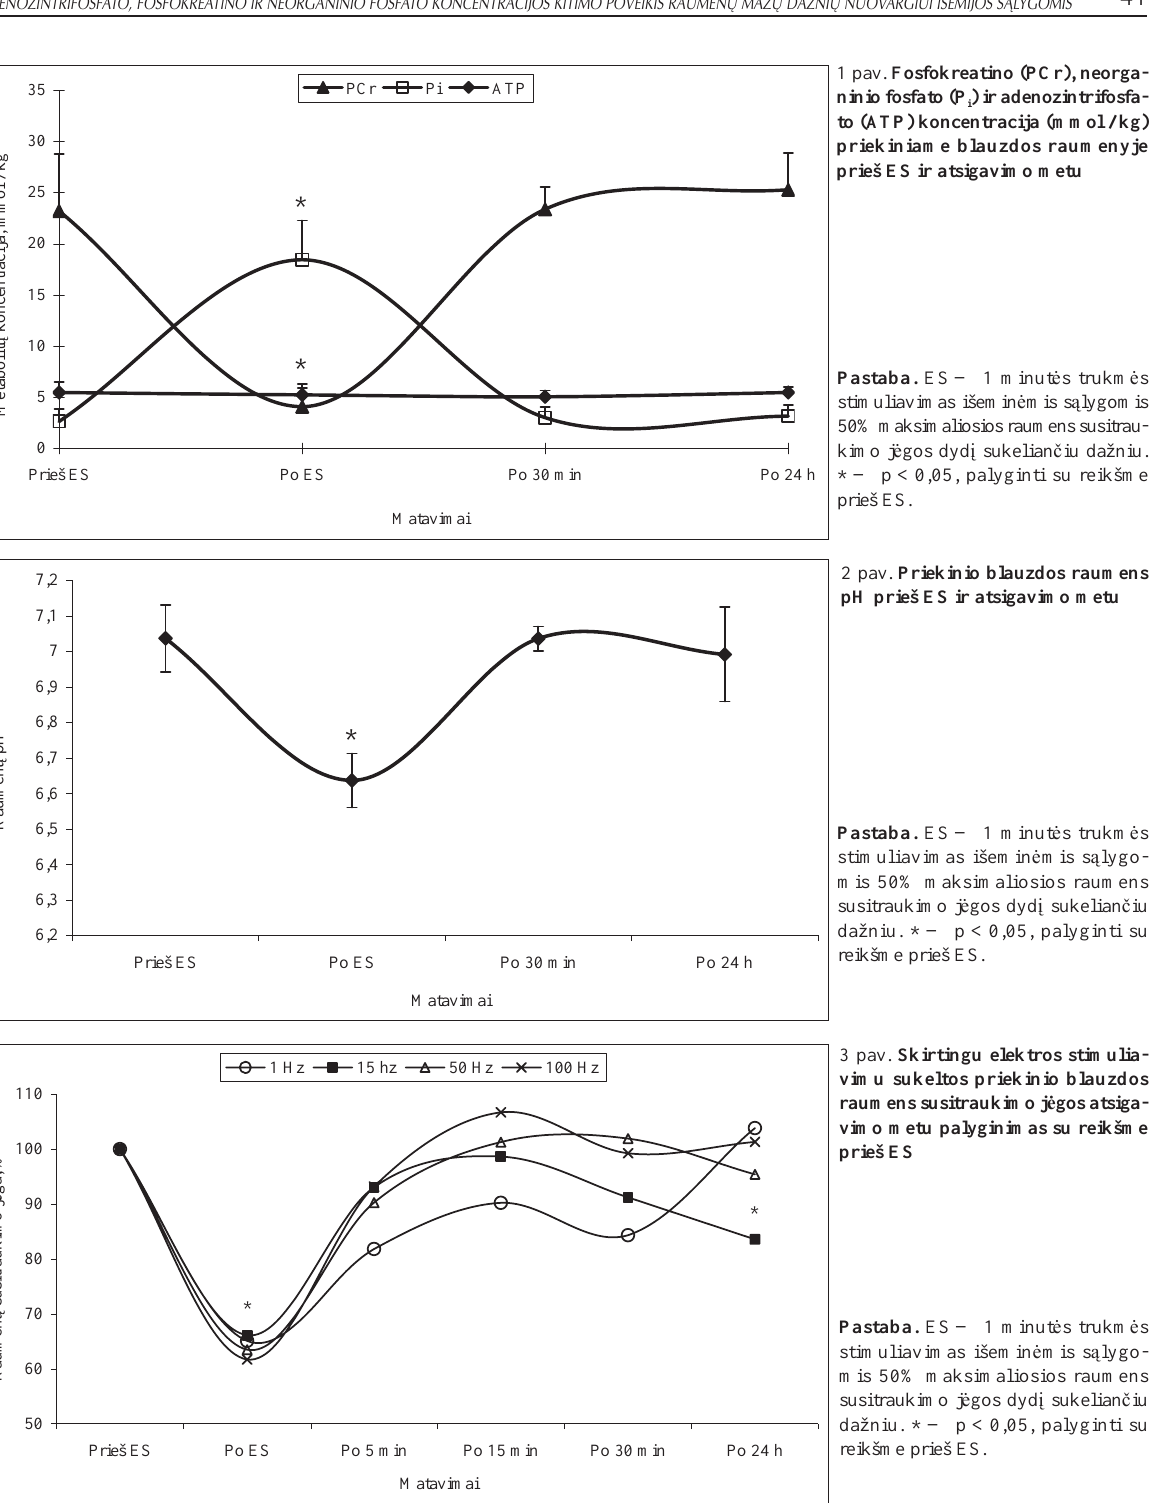
das. Vykstant ATP resintezei iš PCr (hidrolizuojant koncentraci- PCr), šio proceso skilimo produkto P i ja raumenyje kito priešingai PCr kaitai: iš karto po stimuliavimo statistiškai reikšmingai (p < 0,001) padid ė jo, o 30 minut ę gr į žo į pradin į lyg į . Po ES raumens pH reikšmingai sumaž ė jo (p < 0,001), o pra ė jus 30 minu č i ų nuo pradin ė s reikšm ė s labai nesiskyr ė (2